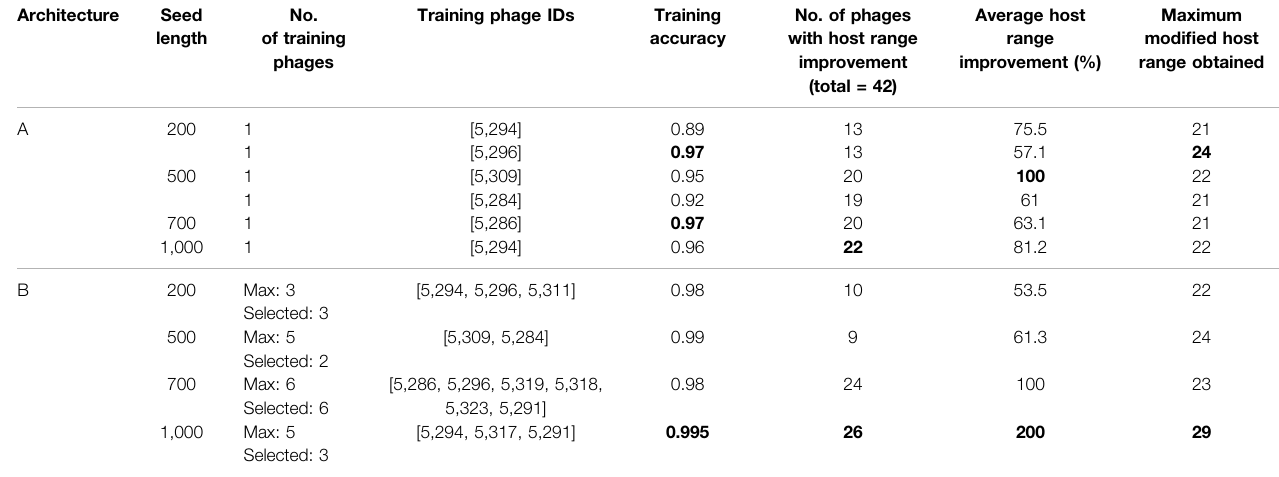
The best obtained results are shown in